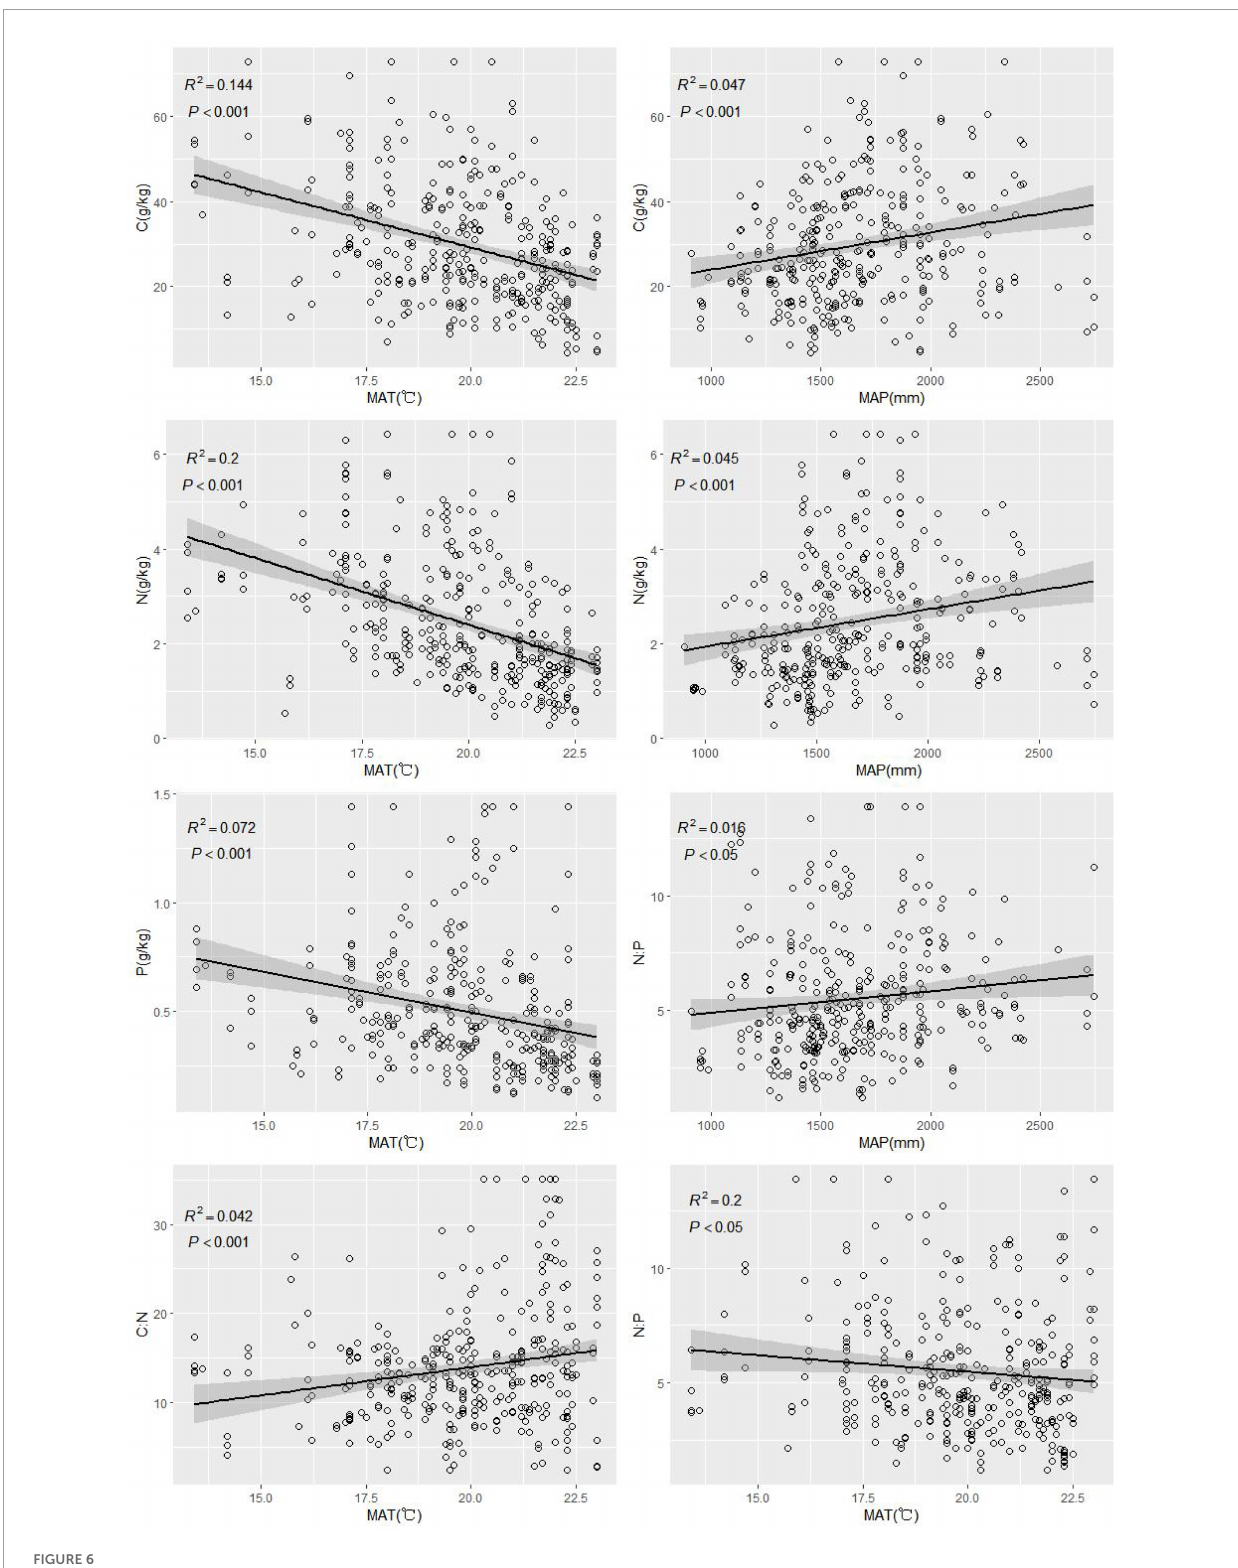
2020; Yu and Chi, 2020). The average N:P value in this study was 5.53, which is consistent with those of Xu et al. (2013) and Hui et al. (2021), who presented soil N:P values of 5.72 and 5.41 in